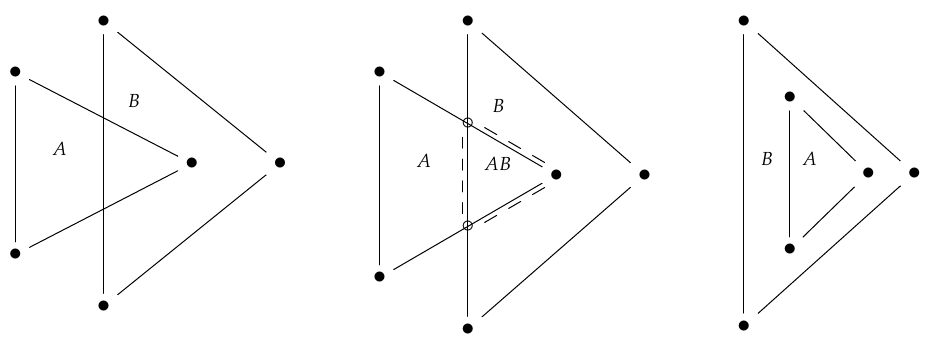
Figure 3. ( Left and middle ): the overlay of two triangles; ( right ): configuration of two triangles with same B-Rep as ( left